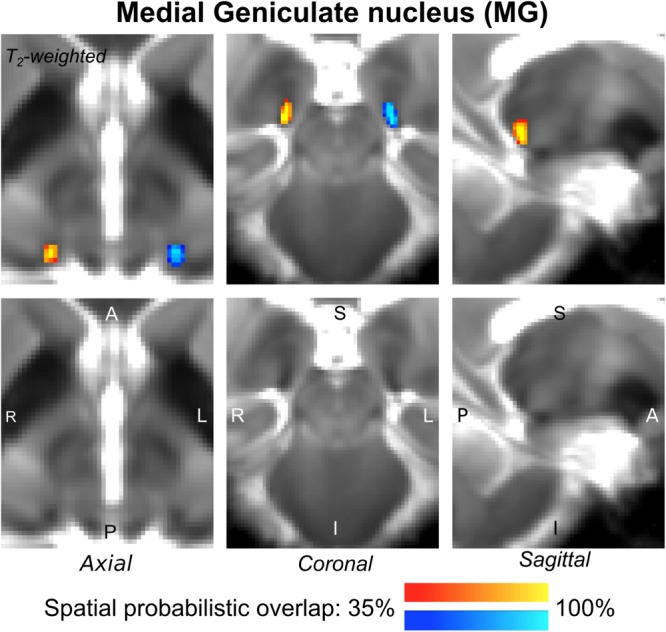
Probabilistic atlas label in MNI space of the MG (left: blue-to-cyan; right: red-to-yellow). The MG was hypointense in T2-weighted MRI; its label is overlaid on the group average T2-weighted image. Very good (i.e., up to 100%) spatial agreement of labels across subjects was observed indicating the feasibility of delineating the probabilistic label of this nucleus, which is a thalamic relay between the IC and the auditory cortex, and thus it is crucially involved in auditory and auditory-motor functions.